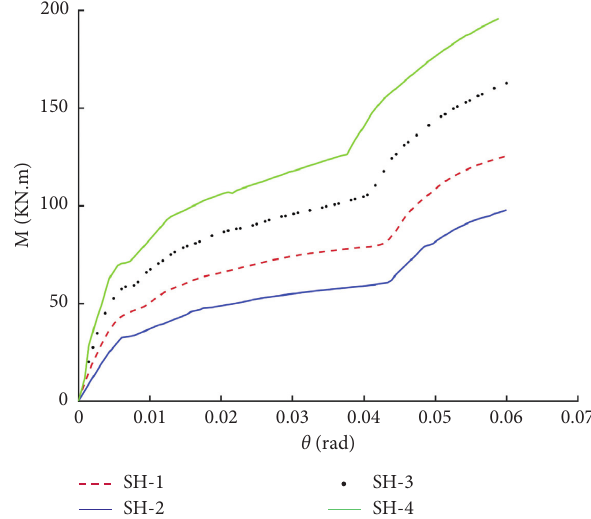
Figure 19: Moment-rotation curves of joints with different beam heights.